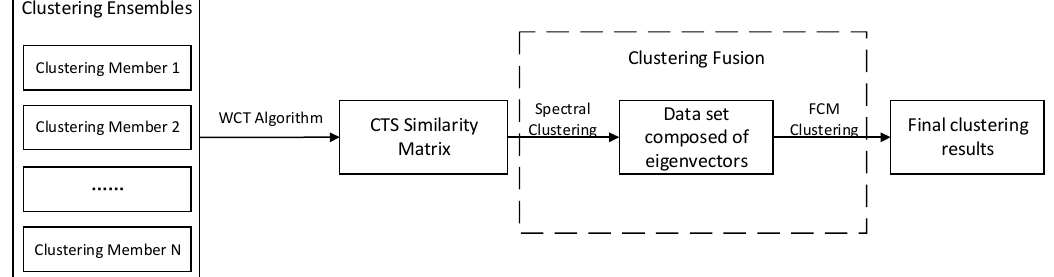
Figure 3. Spectral Clustering with the fuzzy C-means (SC-FCM) clustering fusion algorithm.